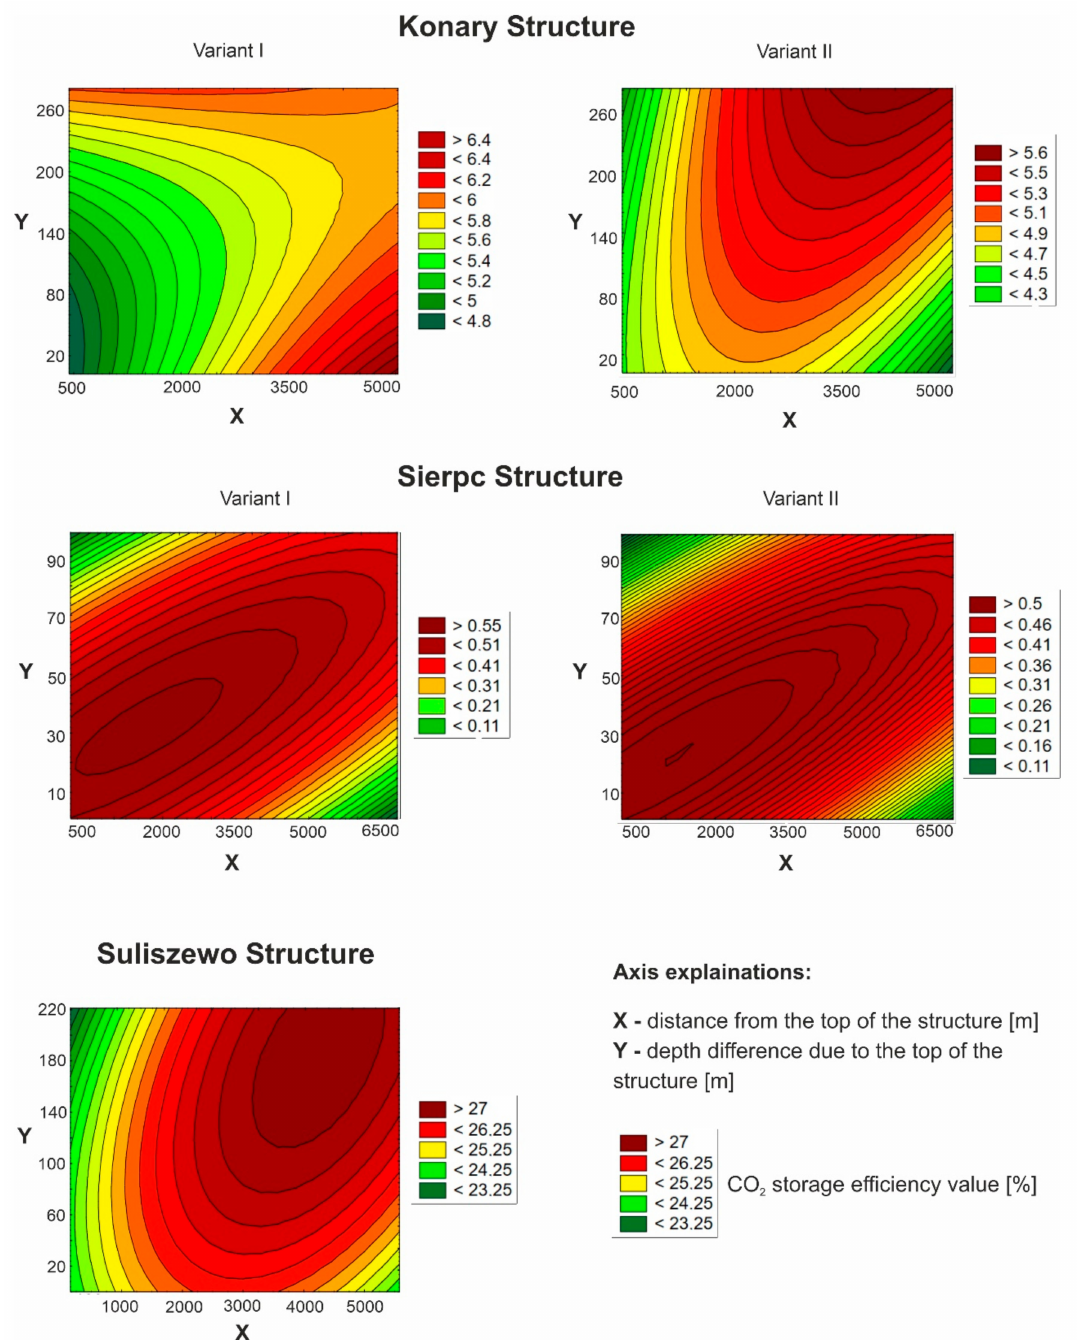
Figure 7. 2D X–Y color plots of CO 2 storage efficiency against the distance from the top of the structure and the depth difference between the top of the Konary, Sierpc, and Suliszewo